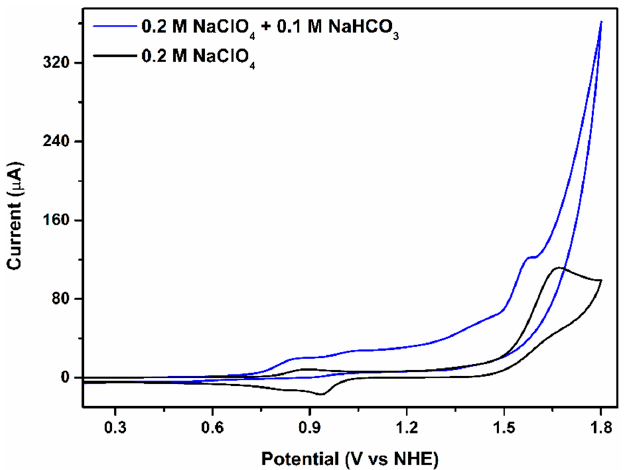
Figure 5. Cyclic voltammograms of a solution containing 1.0 mM Na 3 [Ru 2 (µ - CO 3 ) 4 ] in the presence of 0.10 M NaHCO 3 (pH 8.3, blue line) and 0.20 M NaClO 4 (pH 7.0, black line) scan rate, 50 mV s − 1 under N 2 atmosphere.